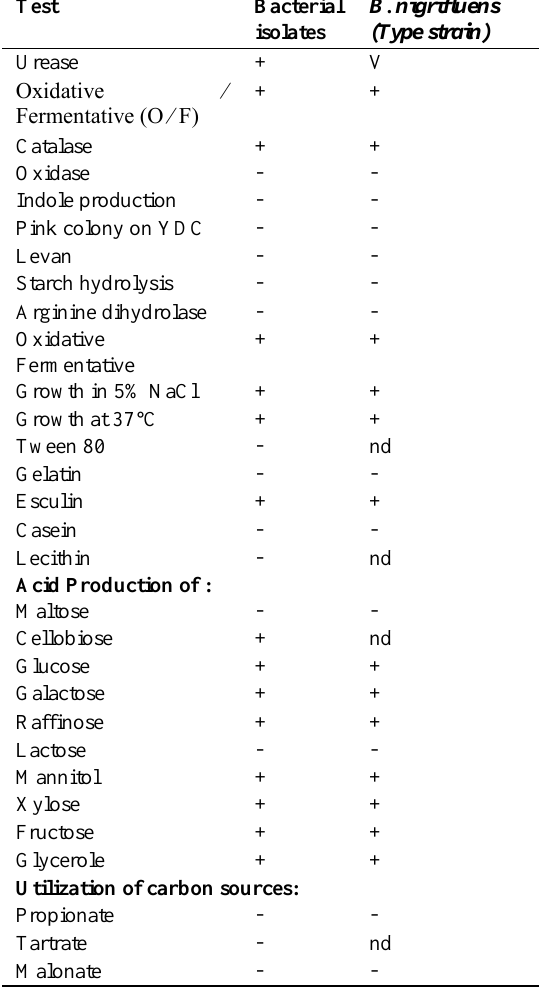
Table.1. Biochemical and phenotypic tests of isolates used in this study compared with the type strain.